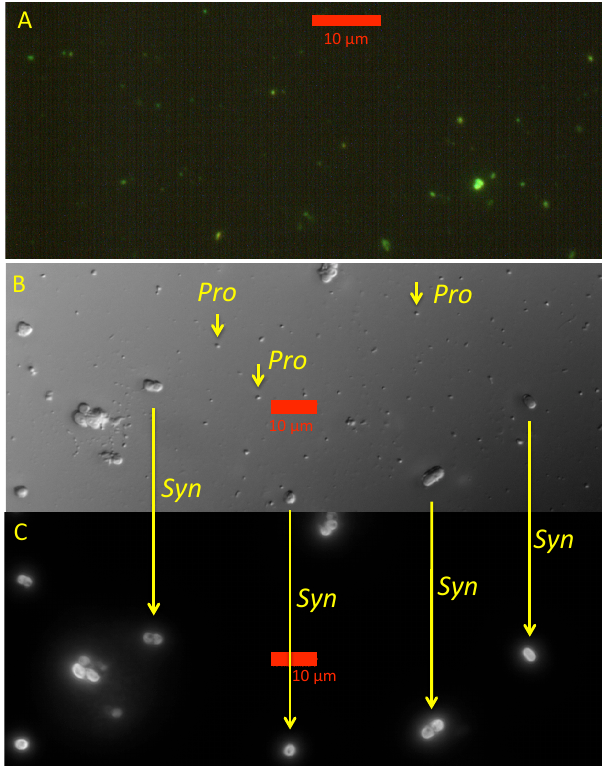
Fig. 3. (A) Epifluorescence microscopy of sub-micron-size cells from a depth of 86m in ice from WAIS Divide, stained with SYBR Gold, concentrated onto a 0.2µm Nuclepore filter and viewed with a FITC filter cube. (B) Mixed culture of unstained Pro (tiny cells) and Syn (larger cells) viewed in Differential Interference Contrast (DIC) microscopy; both Pro and Syn are stable. (C) same field-of- view imaged in EFM with a Chl filter cube using a Hamamatsu C8484 black and white 12-bit CCD camera Pro cells bleach within ∼ 1s whereas Syn takes ∼ 20s to bleach. Scale bars are